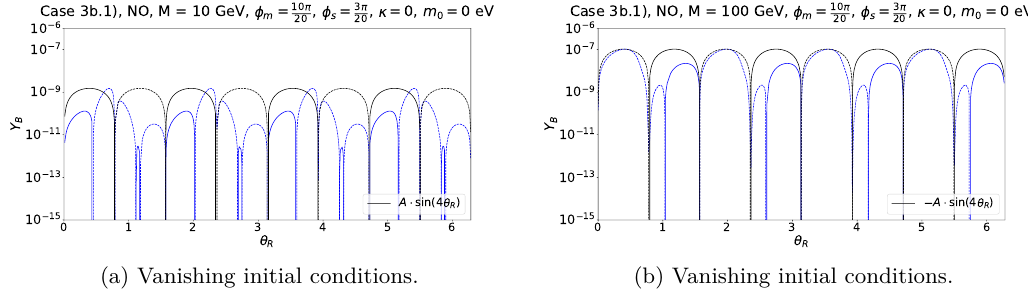
Figure 24 . Case 3 b.1) Y B as function of the angle θ R for a Majorana mass M = 10 GeV (left plot) and M = 100 GeV (right plot). The splitting κ (and λ ) is set to zero. Light neutrino masses follow strong NO. The group theory parameters n , m and s are fixed to n = 20 , m = 10 and s = 3 . We compare the numerical result (blue curve) to the analytical expectation from the CP-violating combination C which is proportional to sin 4 θ (black curve). The coefficient A is given by DEG ,α R (cid:3) . Both negative (dashed lines) as well as positive (continuous lines) values of the BAU Max (cid:2) | Y B | are